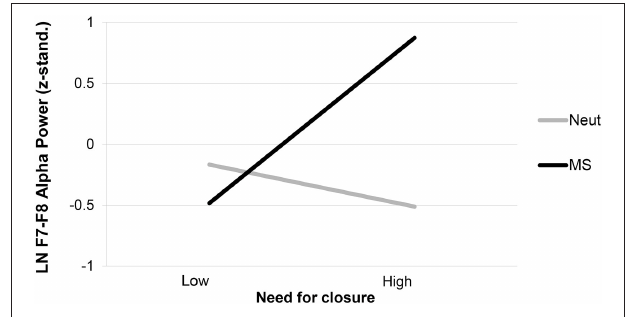
FIGURE 4 | Inhibition of approach motivation measured by LN F7-F8 alpha power ( µ V 2 ) as a function of need for closure (NFC) and mortality salience (MS). Neut, neutral control